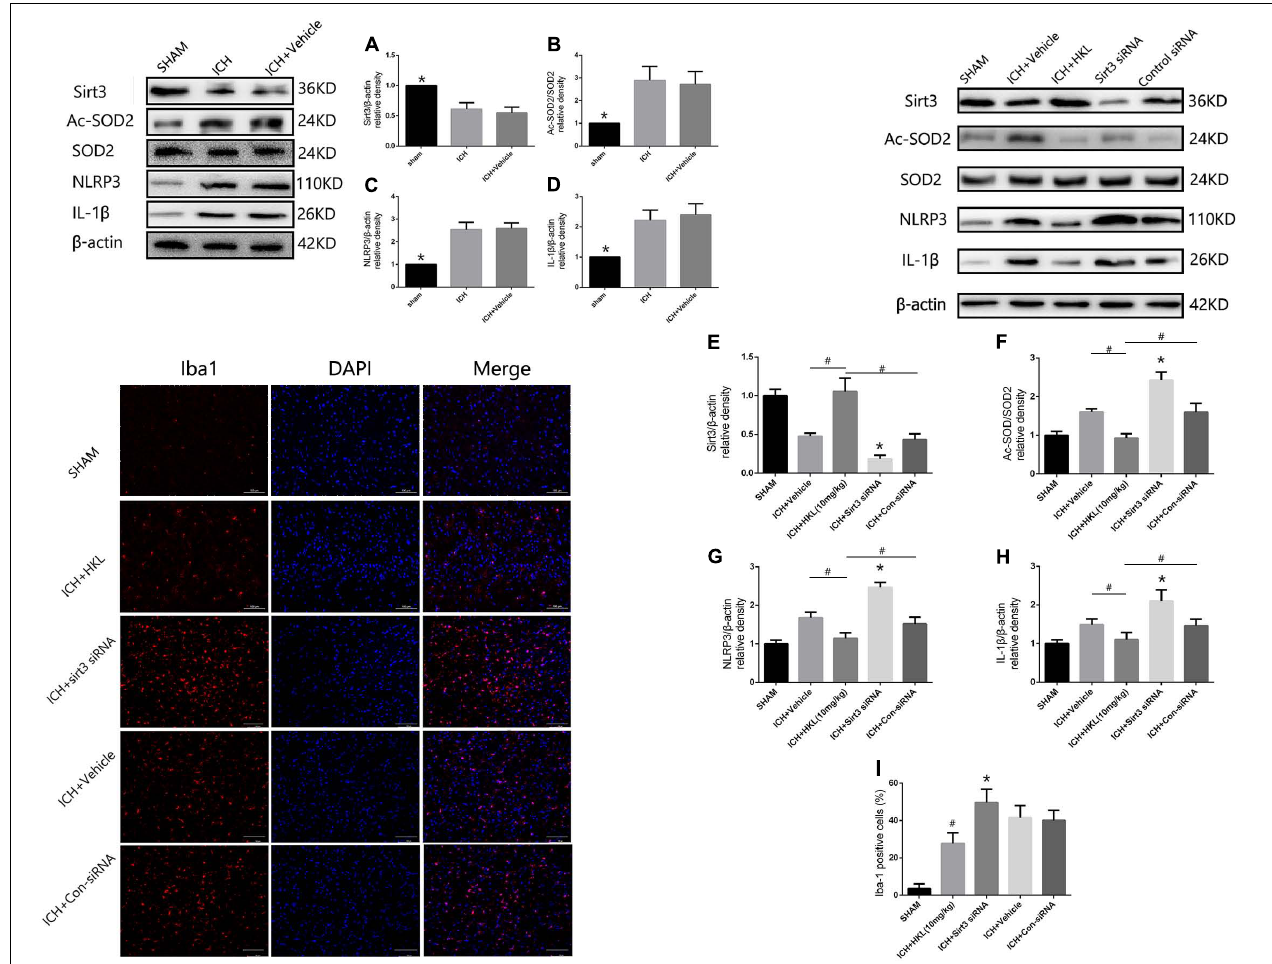
FIGURE 6 | Sirt3 attenuated neuroinflammation through Sirt3–ROS–NLRP3 signaling pathway. (A) Sirt3 expression. (B) Ac-SOD2/SOD2 ratio. (C) NLRP3 expression. (D) IL-1 β expression. ∗ P < 0.05 versus the rest groups. (E) Sirt3 expression. (F) Ac-SOD2/SOD2 ratio. (G) NLRP3 expression. (H) IL-1 β expression. ∗ P < 0.05 versus the rest groups, # P < 0.05 ( n = 6 in each group). (I) Quantification of Iba-1 positive cells (% = Iba-1-positive cells/total cells, ∗ P < 0.05 versus the rest groups, # P < 0.05 versus the rest groups). Scale bars: 100 µ